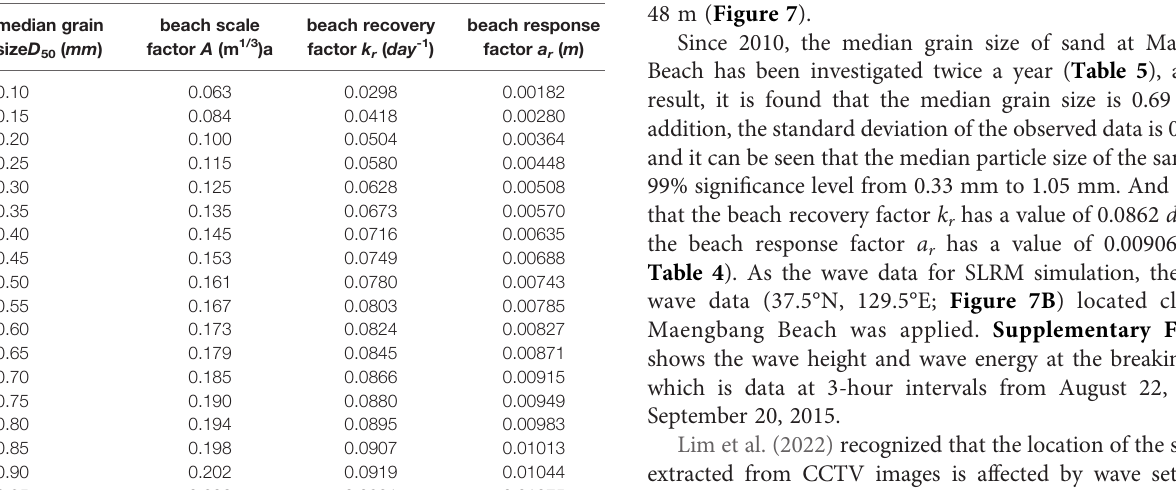
TABLE 4 | k r and a r according to the median grain size of